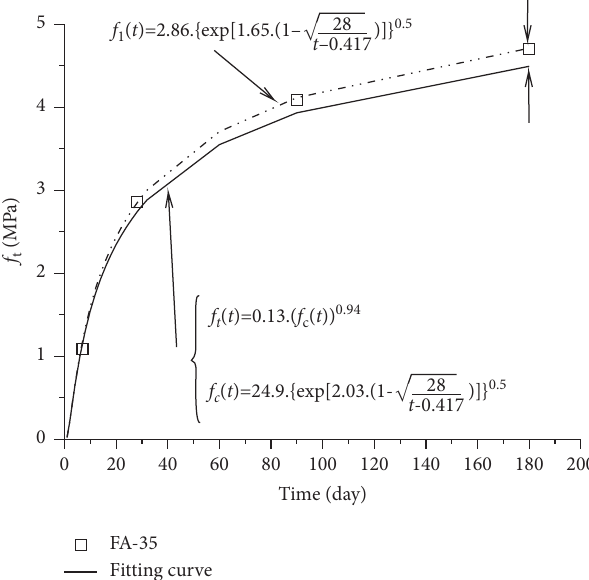
Figure 10: Comparison of the proposed model and test results in tensile strength. Figure 9: Comparison of the elastic modulus models and fitting